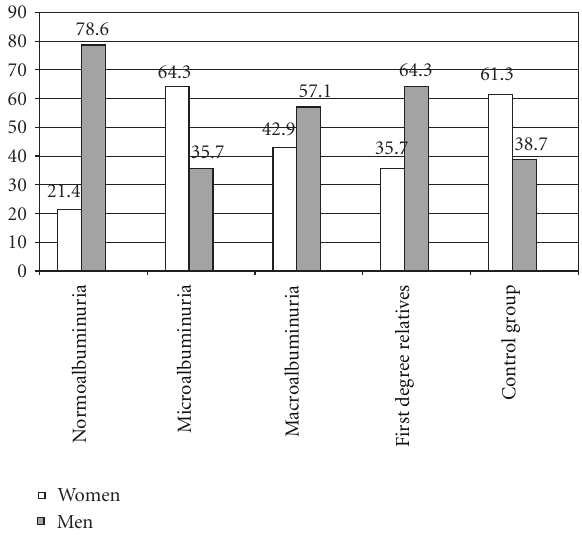
Figure 1: Frequency distribution of sex in the five groups of the